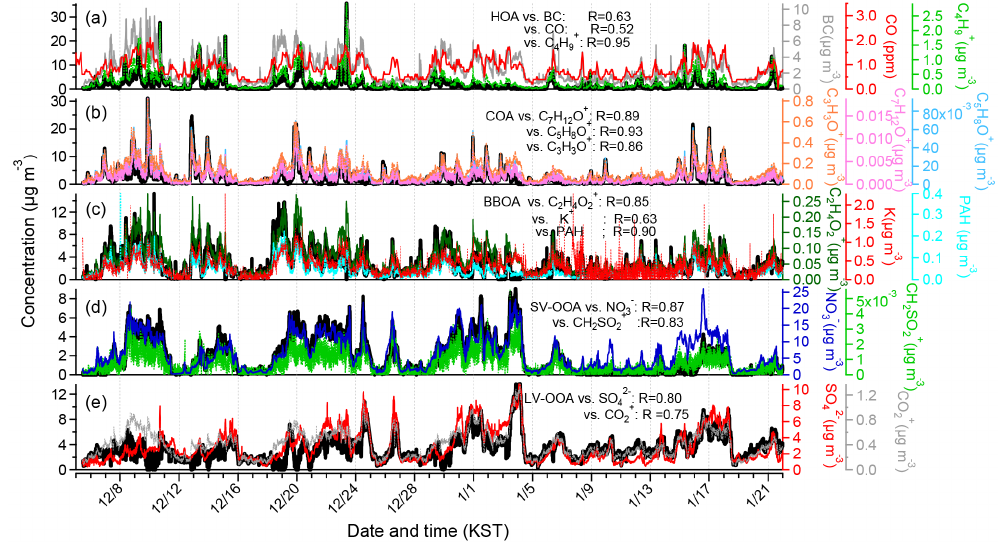
Figure 9. Overview of the results from PMF analysis, including the time series of each of the OA factors and various tracer species.